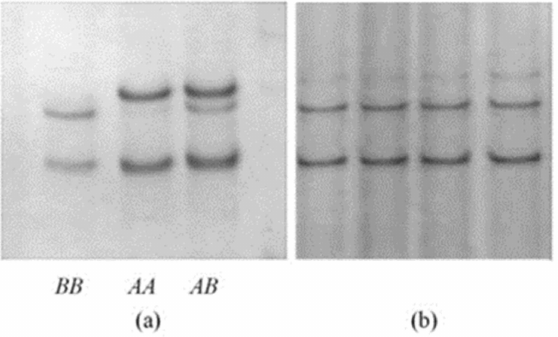
Figure 1. PCR–SSCP detection results of ovine GSKIP . “( a )” is SSCP results of exon 1 amplification region ovine GSKIP ; “( b )” is SSCP results of exon 2 amplification region of ovine GSKIP.